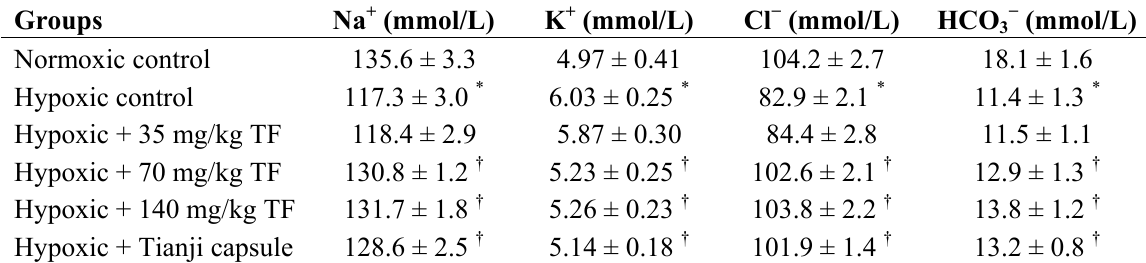
Table 5. Effect of total flavonoids of seabuckthorn on blood electrolyte variables in high-altitude polycythemia